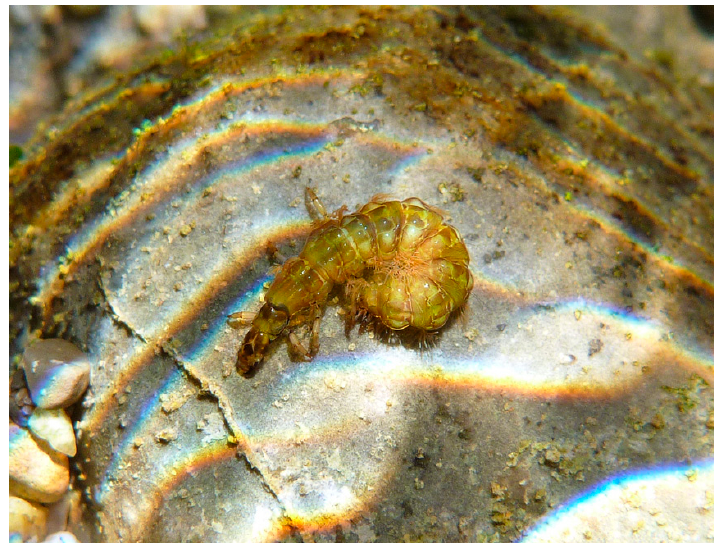
Figure 9. Larva of Rhyacophila sp. (Rhyacophilidae). © W. Graf.